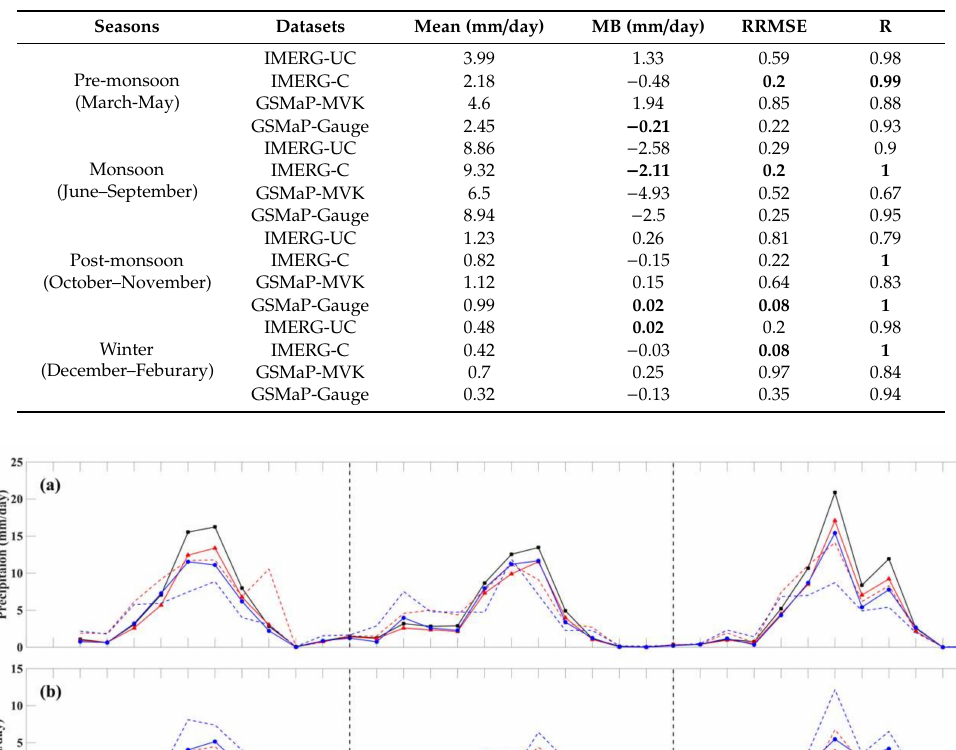
Table A1. Statistical metrics in the di ff erent seasons, derived from the monthly mean precipitation (mm / day) from 2015 to 2016. Bold font indicates the best performance for a given metric.